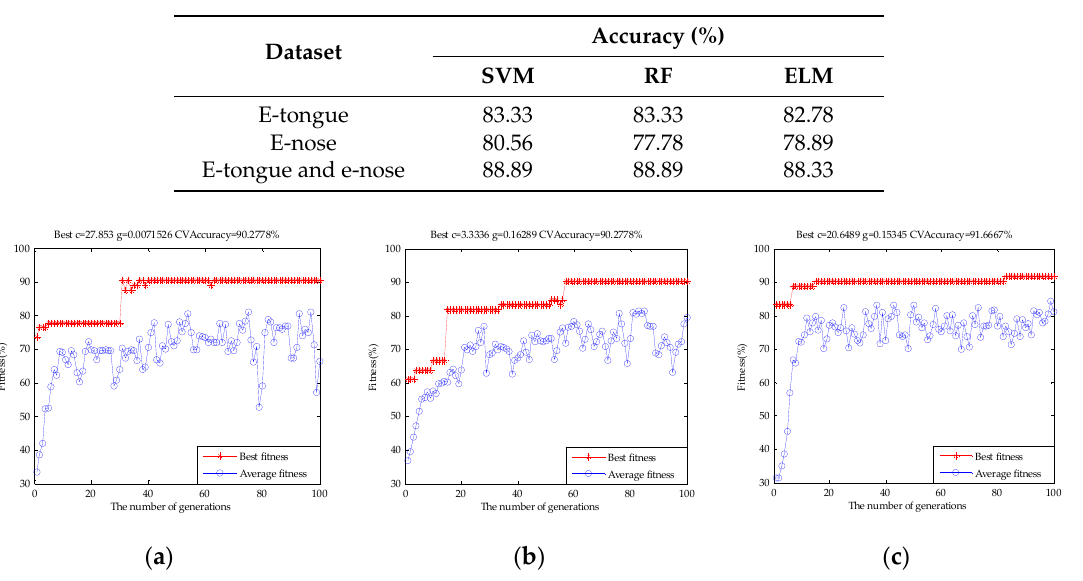
Figure 9. The parameter optimization fitness curve of the SVM: ( a ) e-tongue; ( b ) e-nose; and ( c ) the original fusion set.